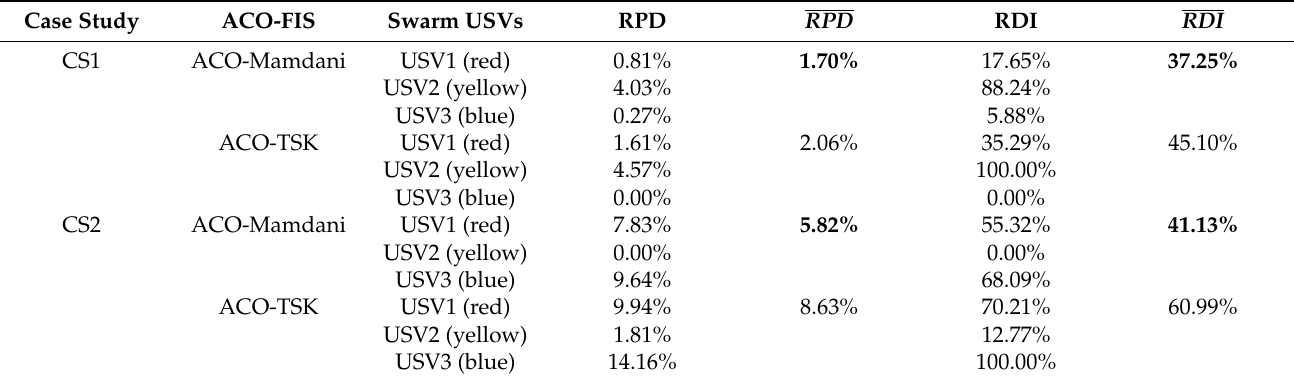
Table 7. Evaluation results of mean relative percentage deviation (RPD) and mean relative deviation index (RDI) for consumption. The best solutions are denoted in bold.